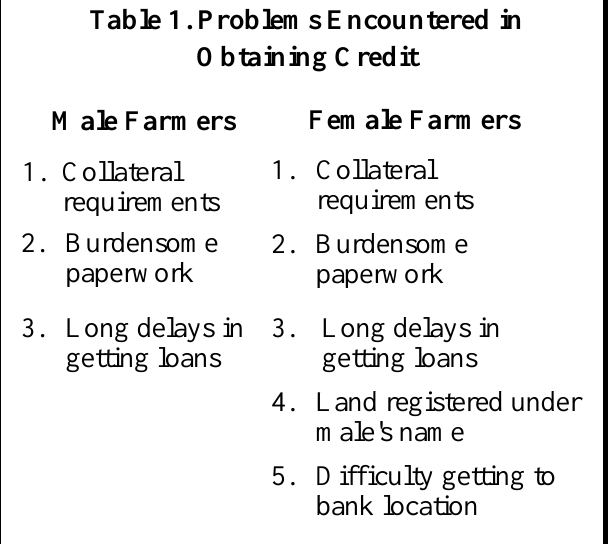
Table 1. Problems Encountered